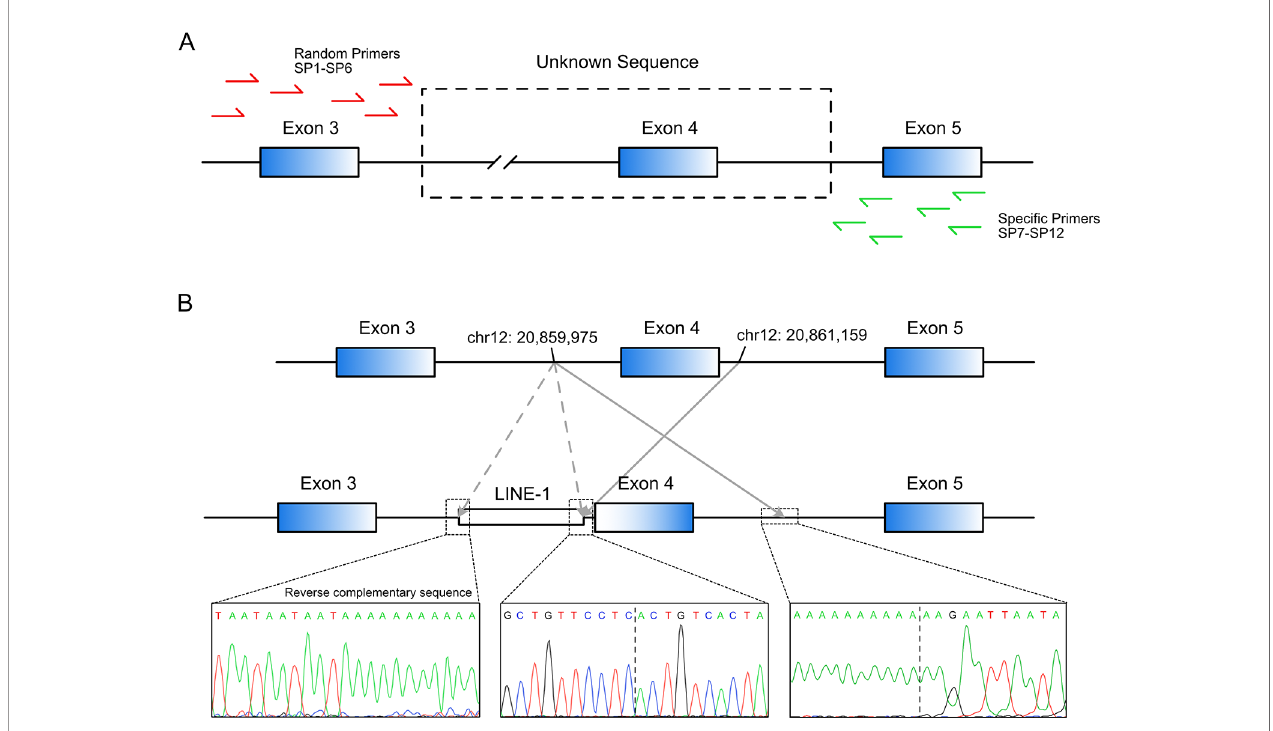
FIGURE 2 | LINE-1-induced DNA inversion identi fi ed in SLCO1B3 . (A) Genome walking analysis was used to identify the unknown sequence between SLCO1B3 exons 3 and 5 in Patient R2. (B) The LINE-1 insertion reversed the fourth exon of SLCO1B3 , 1,040 bp of 5 ′ sequence, and the 3 ′ GTAAGAATTAATAGTGACAGT, end-to-end in the homozygous